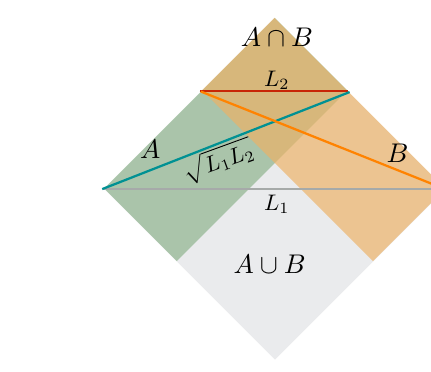
Figure 2 . Setup for the spatial SSA (left) and boosted SSA (right). The causal domains of the intervals are also shown. In both cases, the union and intersection are spatial intervals with lengths L 1 and L 2